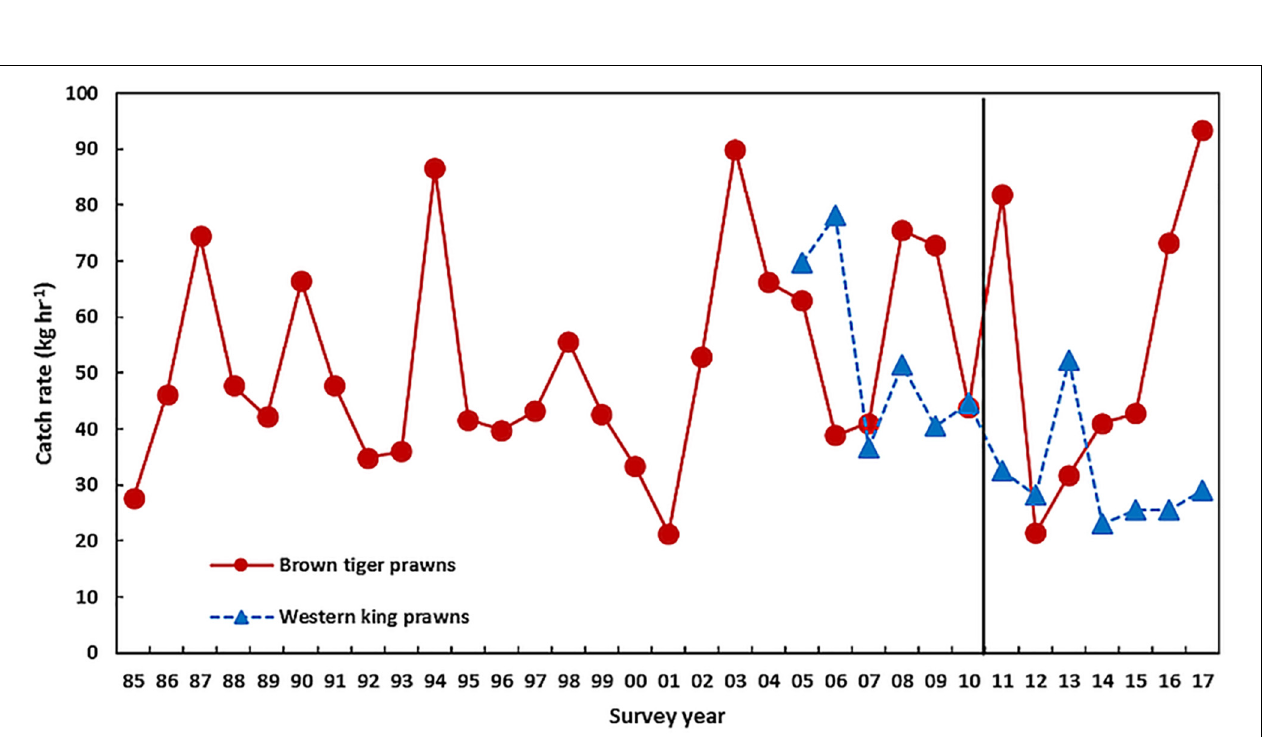
FIGURE 8 | The recruitment abundance (0 +) of brown tiger prawns and western king prawns in Exmouth Gulf from trawl surveys in March–April each year. The vertical line indicates the occurrence of the heatwave.